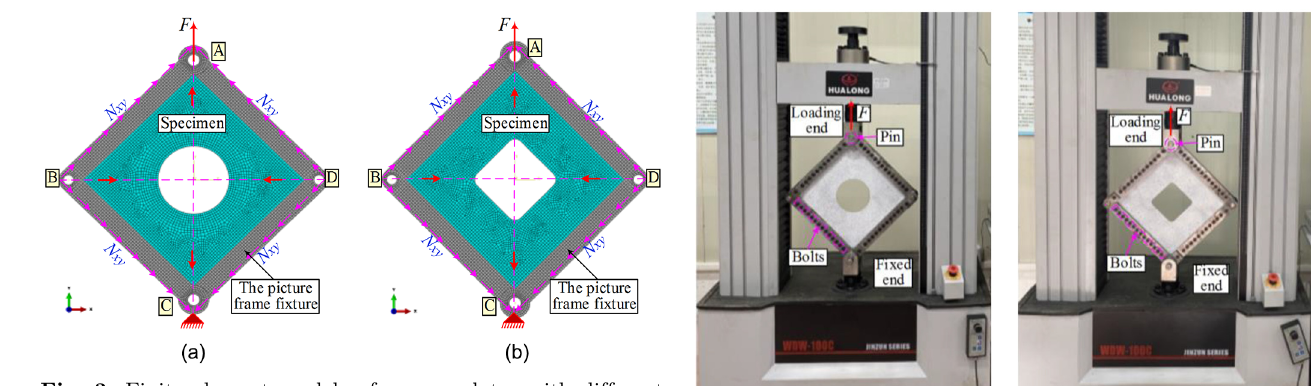
Fig. 3. Finite element models of square plates with different holes. (a) Square plate with circular hole. (b) Square plate with fi llet square hole.